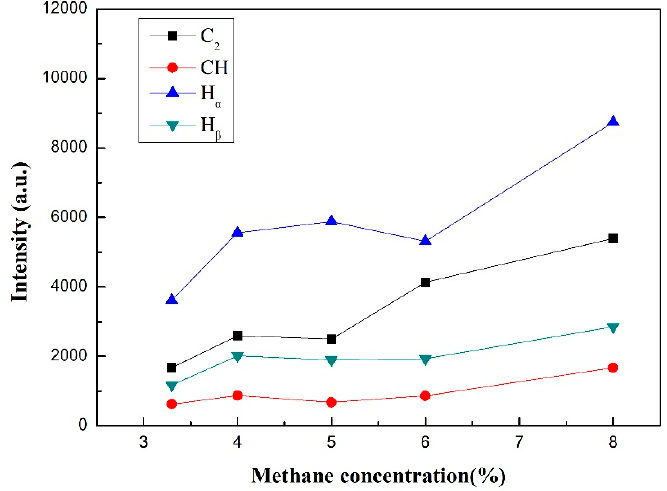
Figure 3. The emission intensity of the C 2 (516.1 nm), H α (656.1 nm), H β (486.1 nm), CH (431.5 nm) with methane concentration varying from 3.3% to 8%.